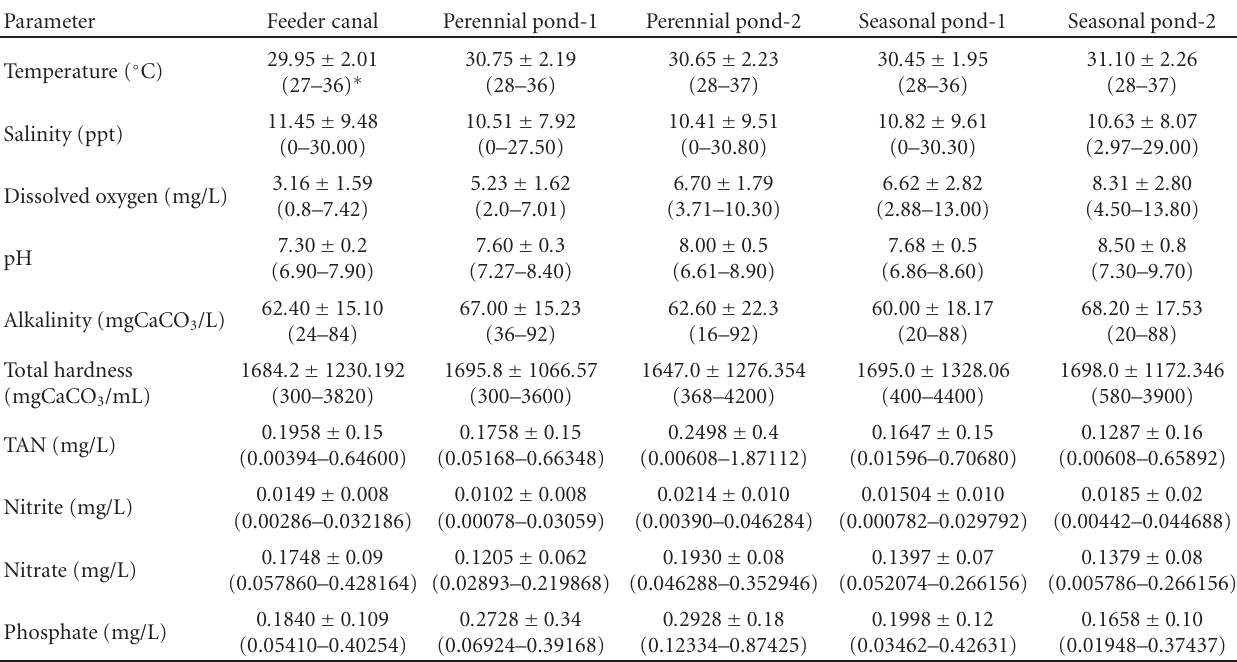
Table 1: Water quality parameters of the feeder canal and the shrimp farms (mean value ± SD).